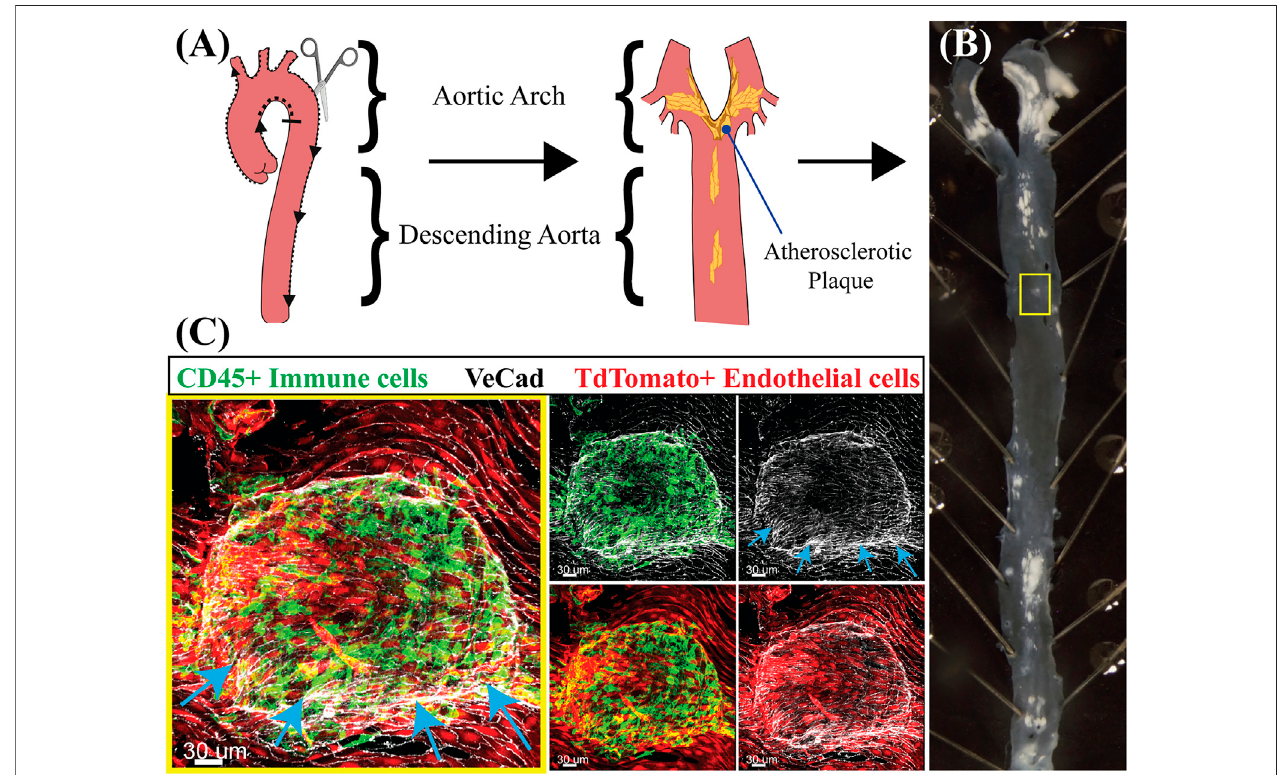
FIGURE 2 | Flow dynamics in atherosclerosis exacerbate the pro-in fl ammatory state of the endothelium. (A) Schematic of an aorta highlighting the aortic arch, where fl owislowandoscillatory,andthedescendingaorta,where fl owishighandlaminar.After fi xation,anaortais fi lletedopenforen-facestaining.Theschematicalso includeswhereatheroscleroticplaques(yellow) areexpectedtobelocated.Created withBioRender.com. (B) AortaofamouseinjectedwithAAV-Pcsk9andfedahigh- fatdietfor3 monthstoinduceatherosclerosis.Notethedistributionandlocationofplaques(white)predominantlyandatlargersizedregionsoflow,oscillatory fl ow andbranches.Theyellowboxidenti fi esasmallplaquethatwassubsequentlyimagedin (C) . (C) En-facestainingoftheaortafrom (B) intheregionenclosedbytheyellow box.Thestainingshowsanatheroscleroticplaquewhichisdevelopingundertheendotheliumraisinguptheintimalayerandahostofin fl ammatorycells(endothelialcells are Tdtomato +, red, and cell borders marked by VeCad in white). Arrows point to the protruding plaque. Note the large number of CD45 + immune cells (green) that are predominantly associated with the endothelial cells covering the